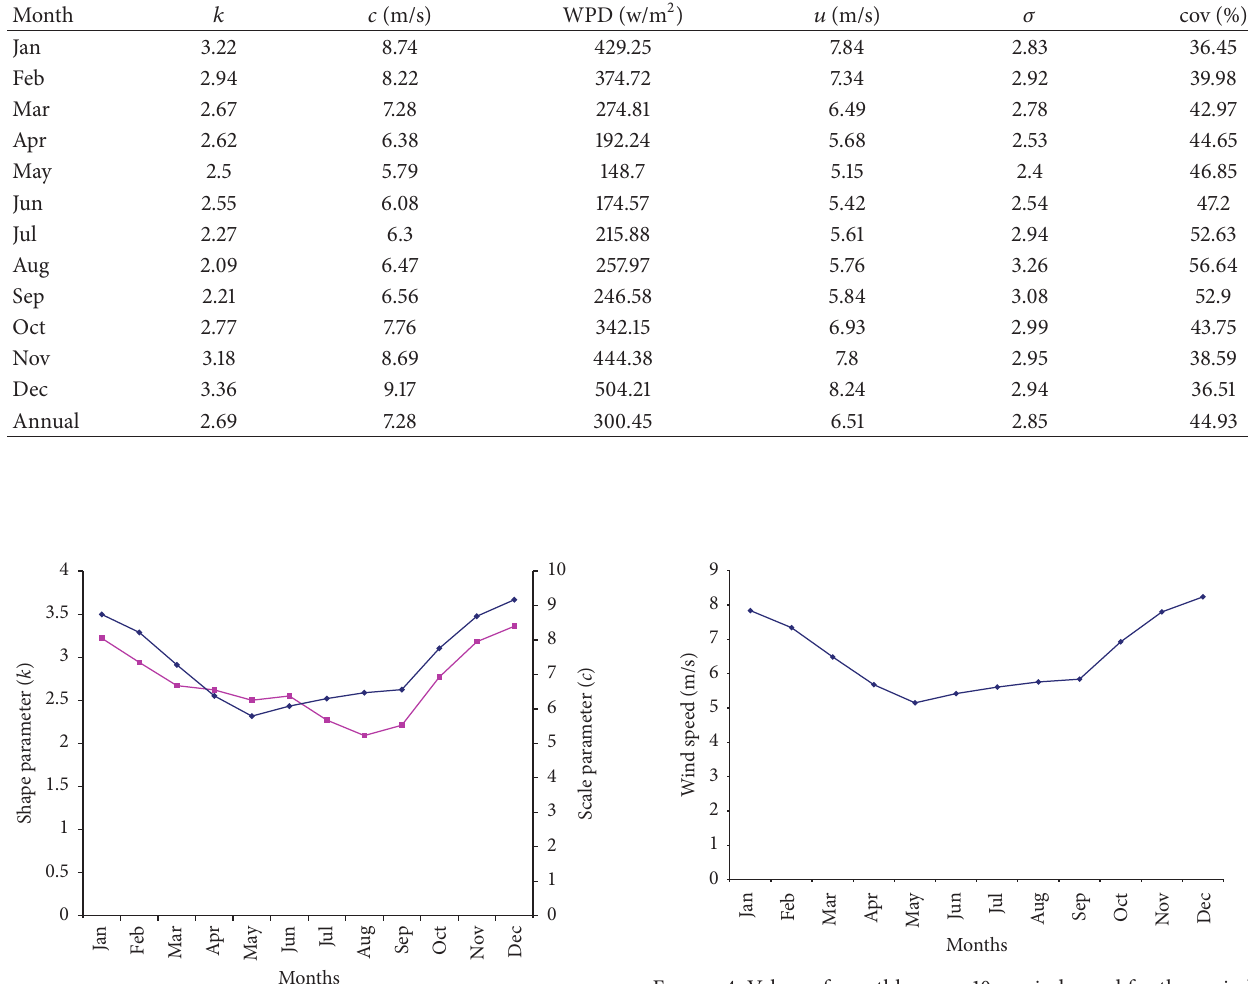
Table 2: Monthly and annual mean Weibull parameters, wind power density, wind speed, standard deviation, and coefficient of variation.